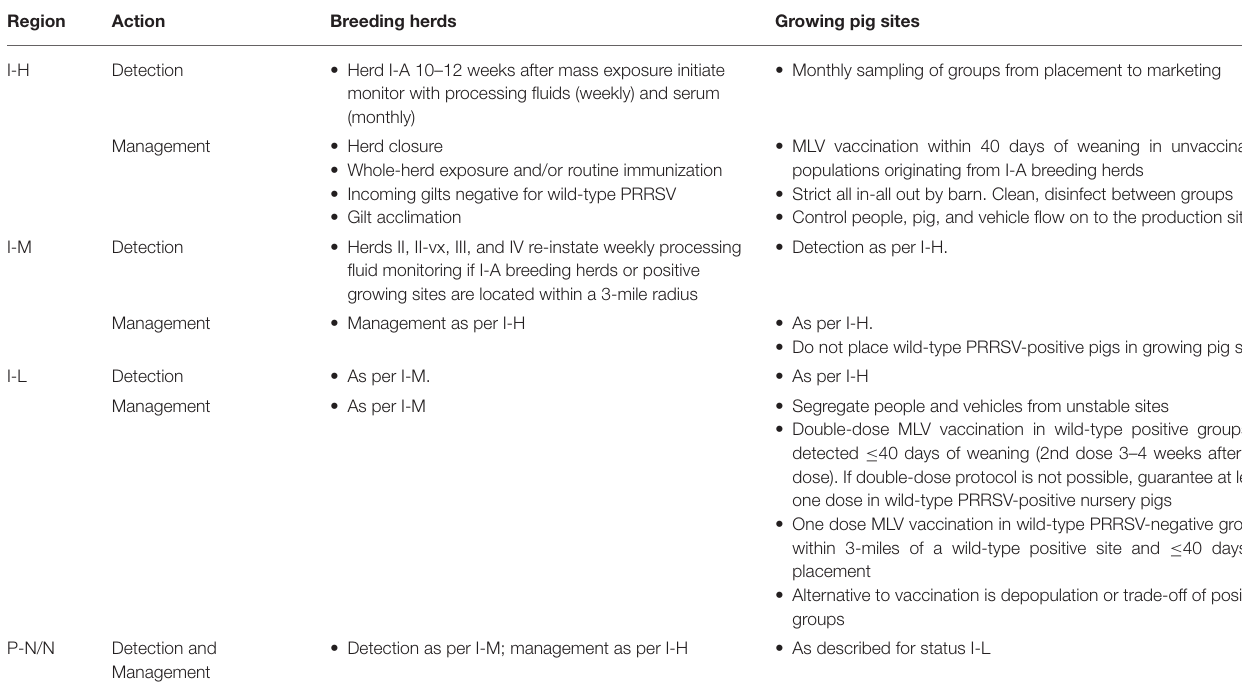
TABLE 2 | Guidelines for control protocols in wild-type PRRSV-positive herds within regional status.